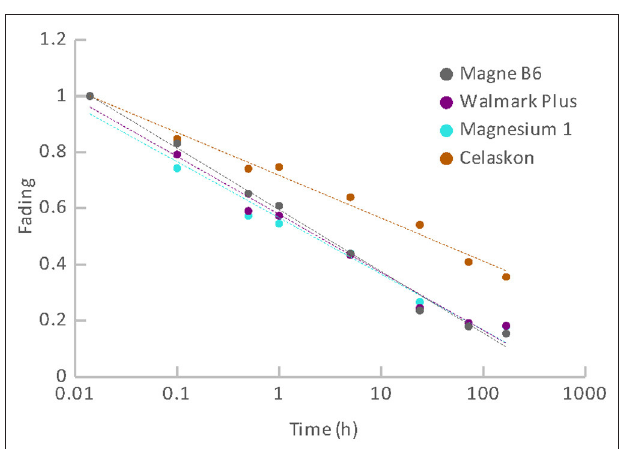
FIGURE 12 | Fading for the group of food supplements.